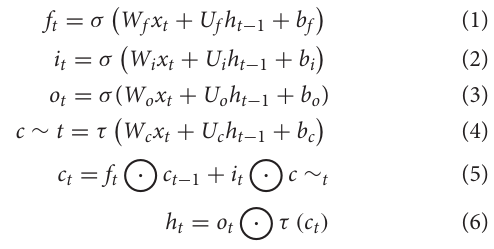
attribute has 67 missing values (43%), accounting for < 10% of the total